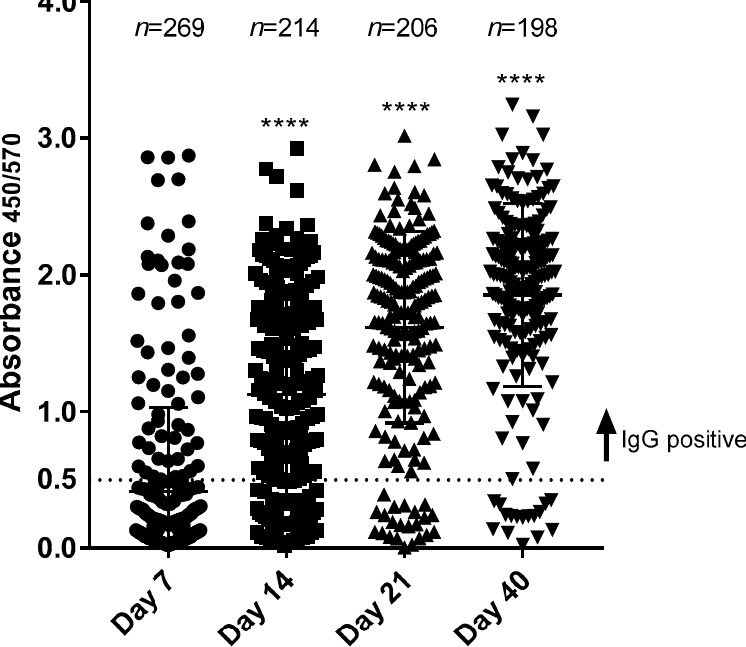
Figure 5. IgG seroconversion of COVID-19 RT-PCR positive patients evaluated with UDITEST-V2G ® . Serum samples from COVID-19 RT-PCR positive patients were evaluated on day 7, 14, 21, and 40